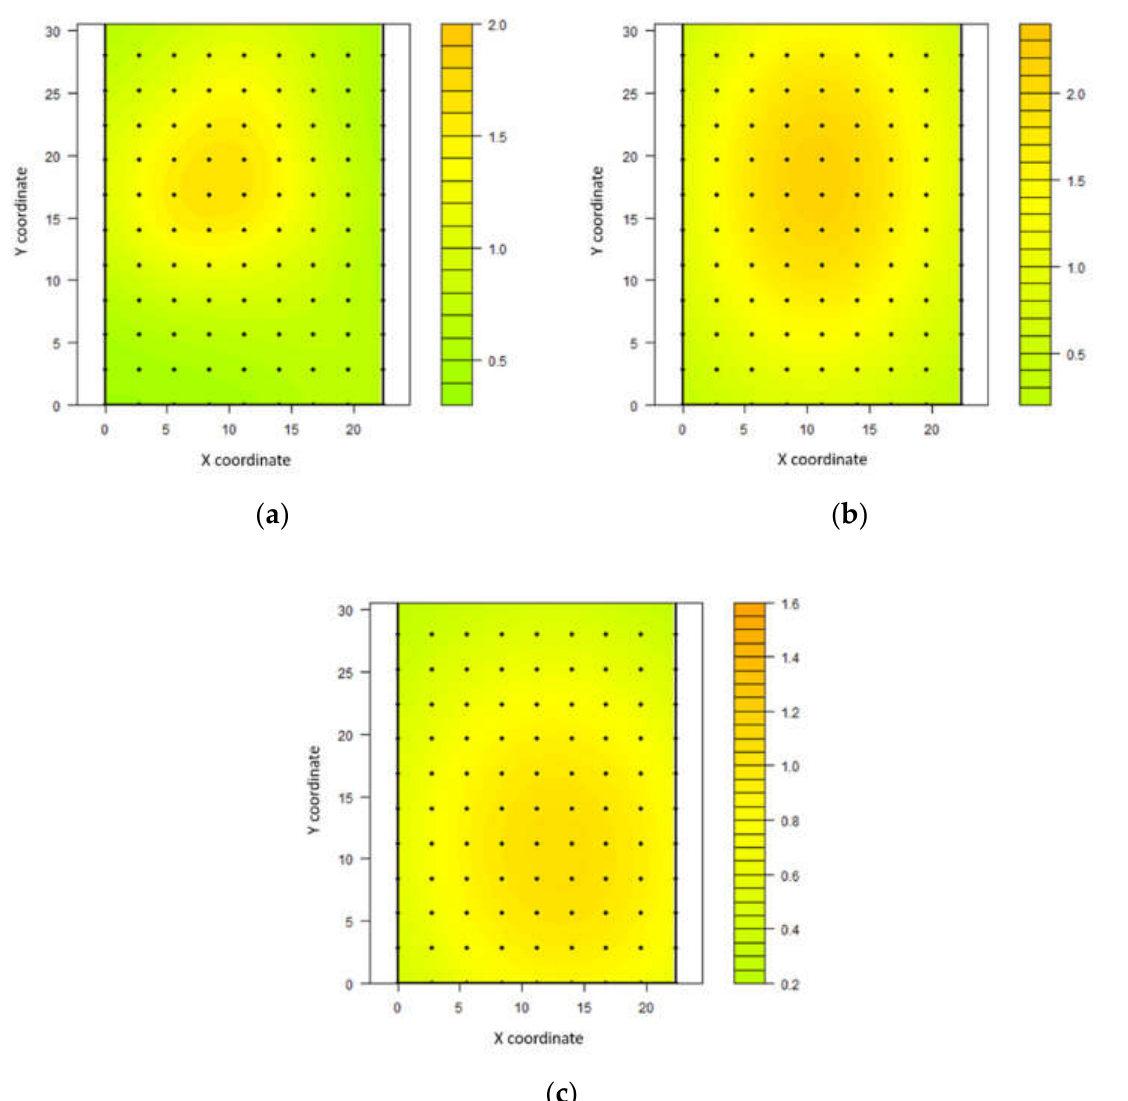
Figure 4. Spatial distribution of wind speed in compost-bedded pack barn (m s −1 ) between 09:00 and 12:00 h ( a ), between 12:00 and 15:00 h ( b ), and between 15:00 and 18:00 h ( c ).